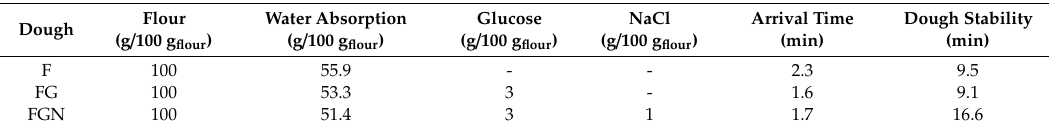
Table 1. Doughs formulation and characterization (F = flour only; FG = flour added with glucose; FGN = flour added with glucose and